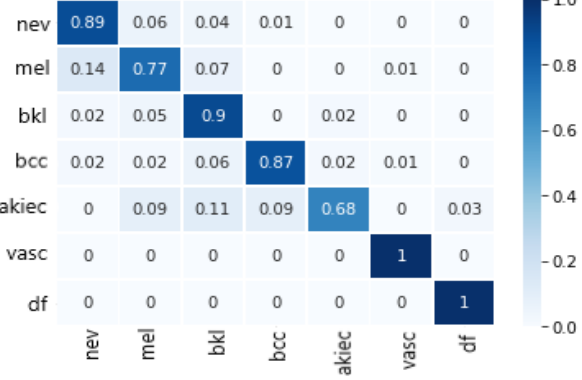
82.49 From the tested model architectures, DenseNet169 achieved the highest values for all metrics, while DenseNet121 the second highest. In contrast to our expectations, Dense- Net201 did not do better than the other, less deep DenseNet models. It seems that the size of the training set was no more adequate for deeper training than that of DenseNet169. From the rest of the models, InceptionResNetV2 and VGG16 did better than the others,